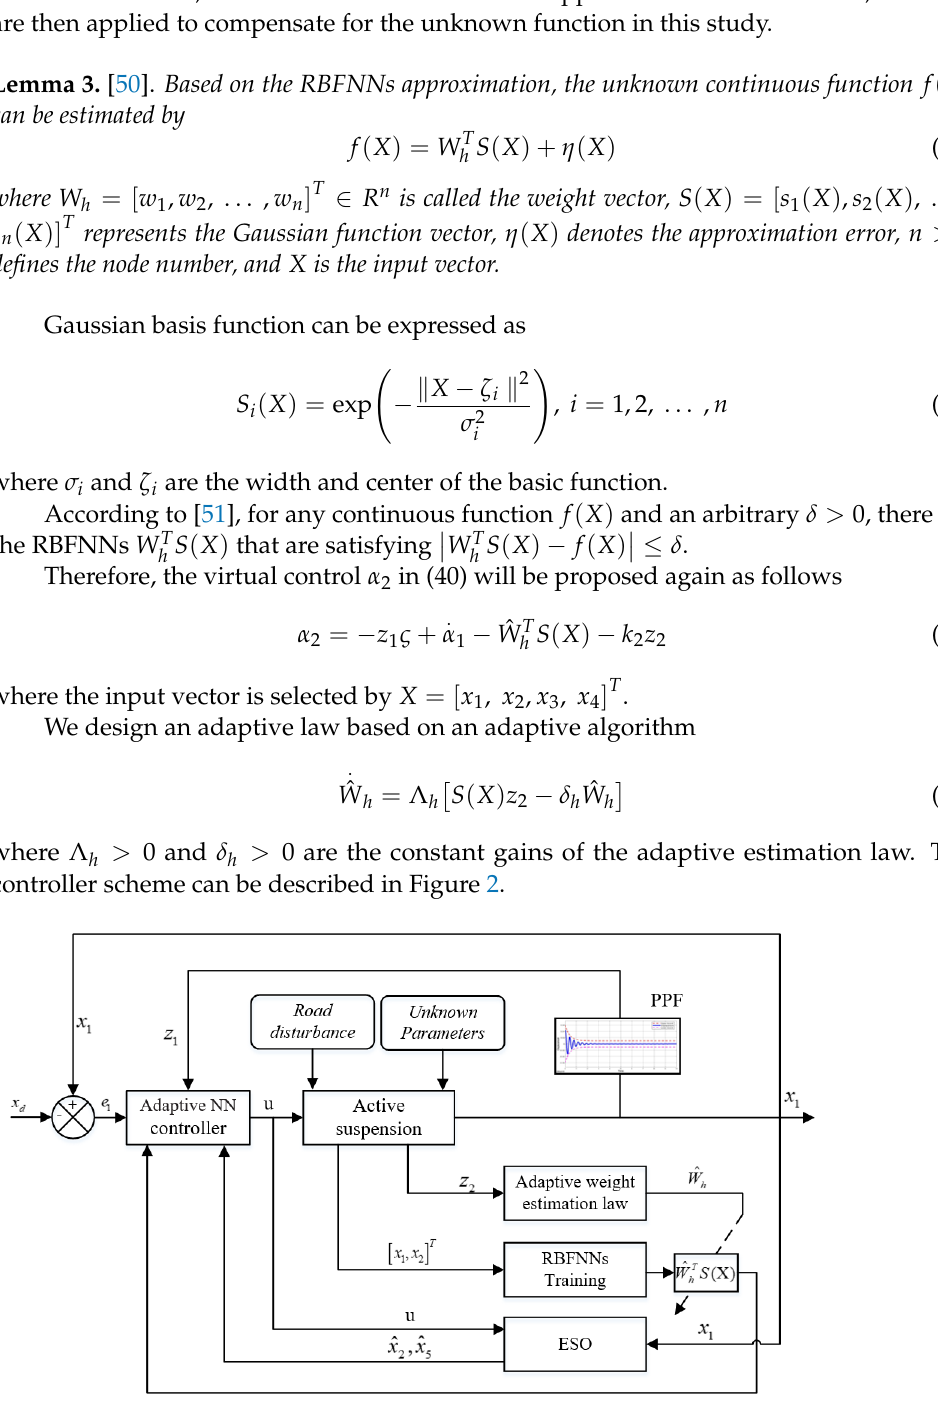
Figure 2. Structure diagram of adaptive neural backstepping controller design with PPF and ESO.